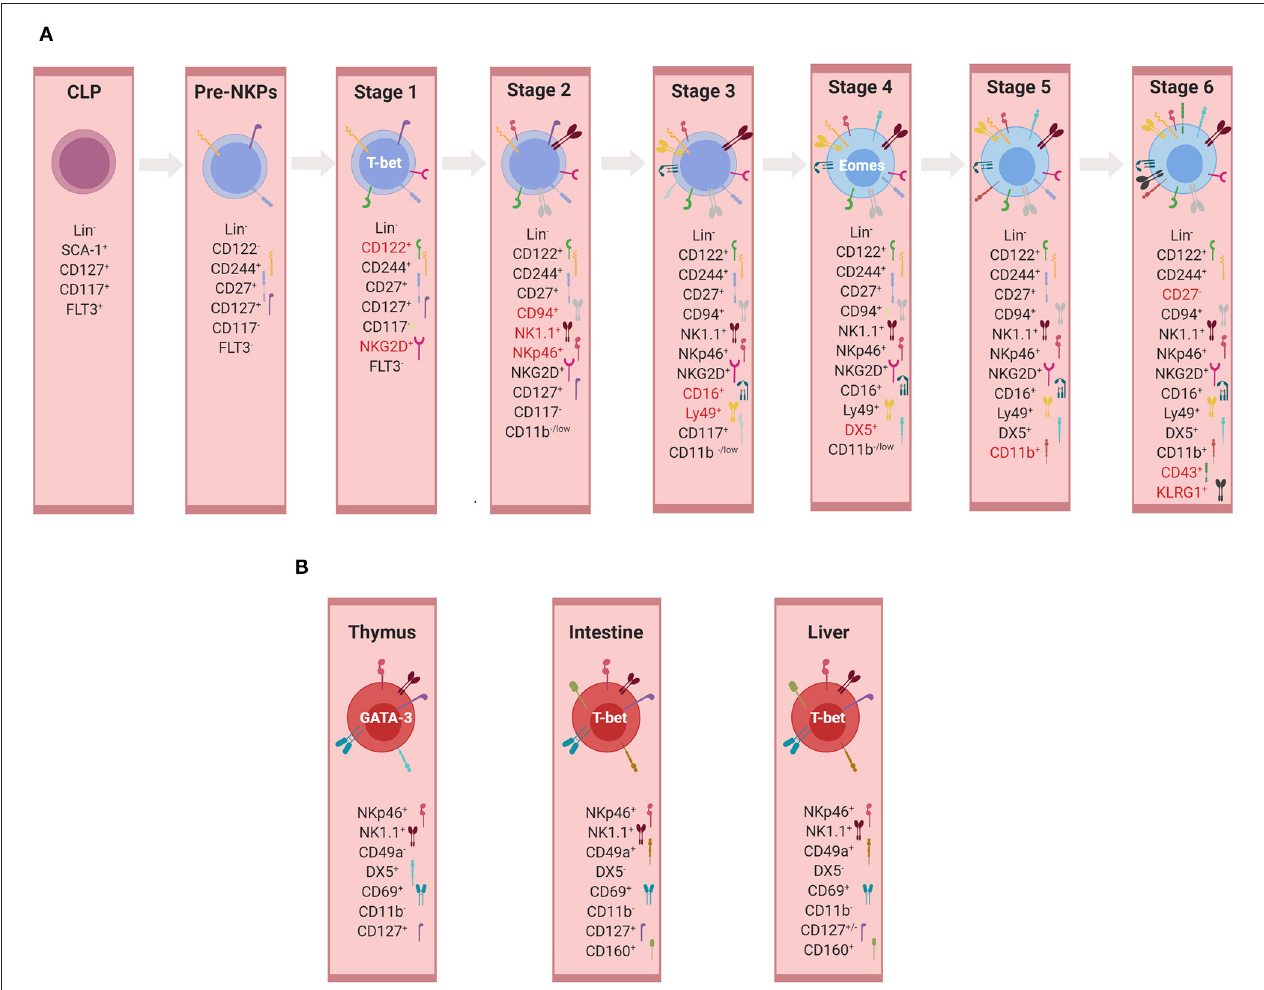
FIGURE 3 | Development of NK cells and ILC1s. (A) Developmental stages of murine conventional NK cells. Representation of markers used for the identification of individual developmental stages. Markers highlighted in red represent those expressed mainly in the given subset and therefore important for its identification. At each stage, the expression of the listed markers is depicted as “ + ”, whereas the absence of expression is indicated by “–” or alternatively “low.” (B) Tissue-specific non-conventional NK/ILC1 subsets. Representation of markers used for the identification of non-conventional/ILC1 subsets in thymus, intestine, and liver (illustrations created with